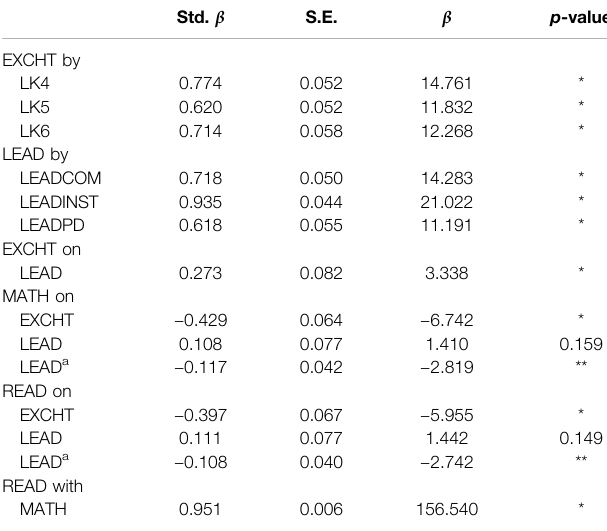
TABLE 2| Standardized factor loadingsand signi fi cance valuesofthe fi nal model. Std.